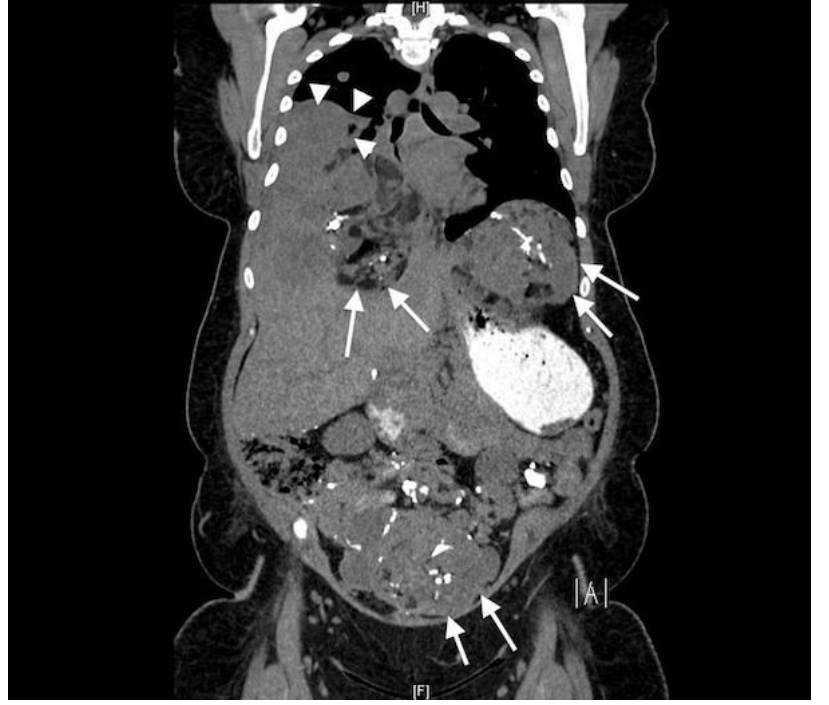
FIGURE 1. Computed tomogram of the chest and abdomen showing heterogeneous subdiaphragmatic and pelvic masses consistent with previously diagnosed teratoma (arrows) and a homogeneous mass contiguous with the teratoma in the right hemithorax, later found to be a sarcoma